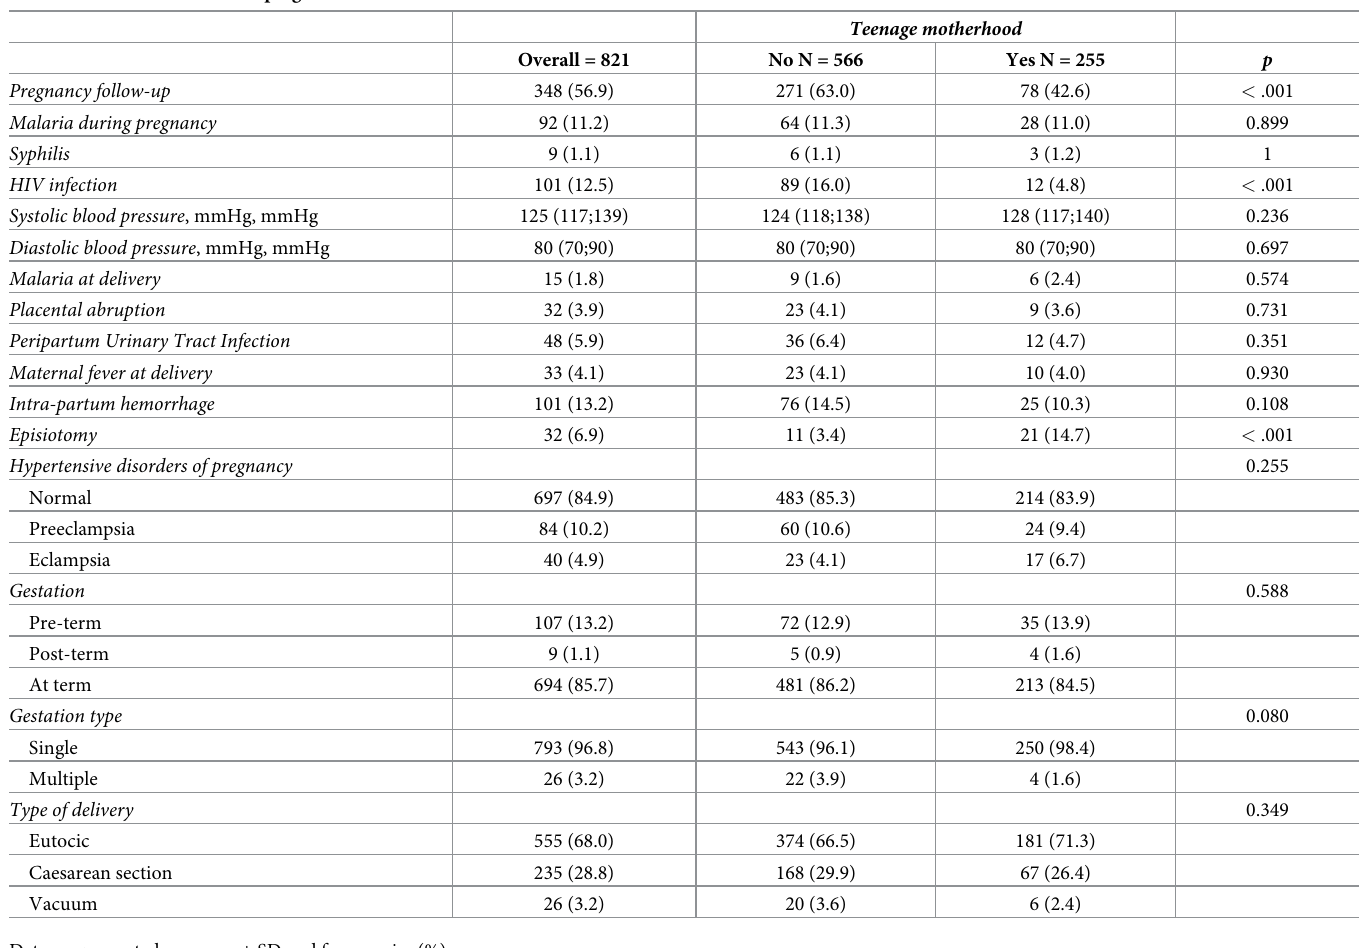
Table 2. Characteristics of the pregnancies and deliveries.